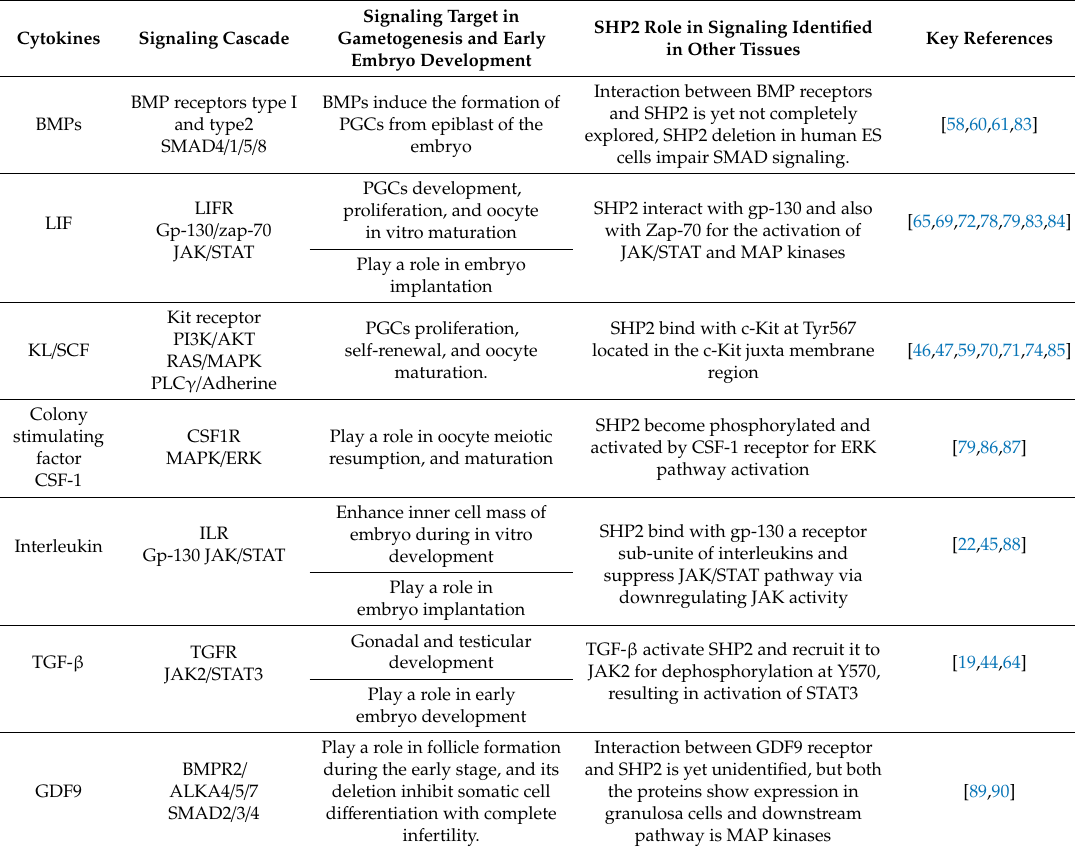
Table 2. Cytokine signals and SHP2 activation in gametogenesis and early embryo development and